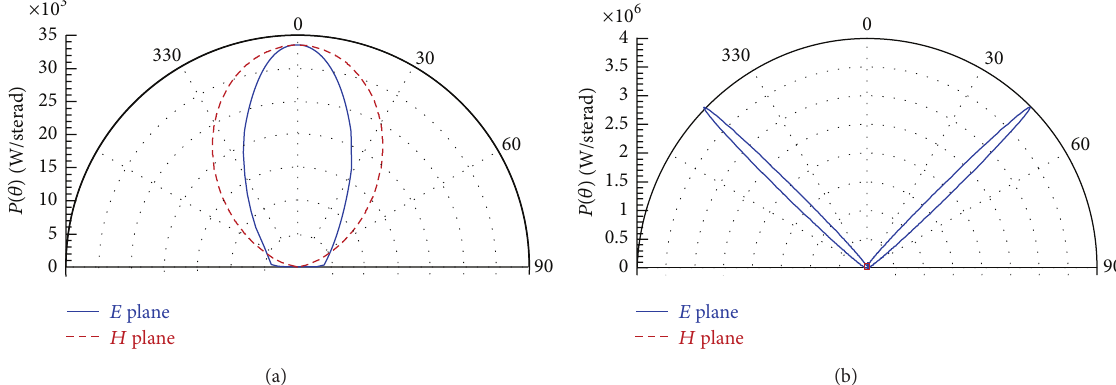
Figure9:Radiationpatternsinthe 𝐸 and 𝐻 planesatdifferentfrequenciestoshowthescanningfeaturesoftheproposedantenna.Parameters: /300 at 𝑓 = 1 GHz and 𝐵 = 47.75 . (a) 𝑓 = 0.8 GHz and (b) 𝑓 = 1.3 𝑏 = 𝜆 0 𝑓